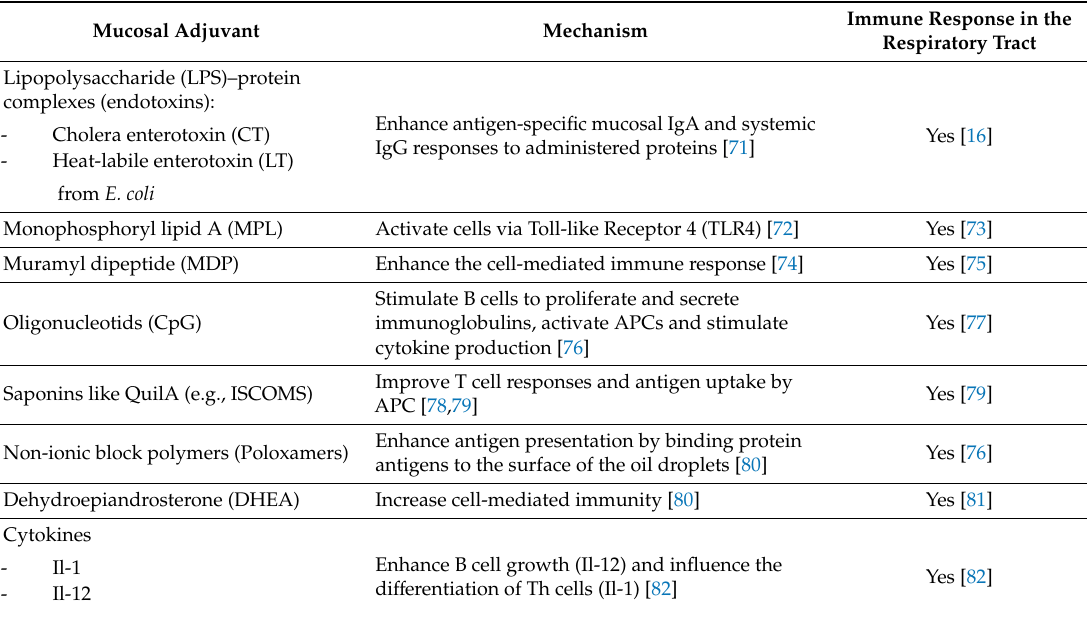
Table 4. Mucosal adjuvants in the respiratory tract